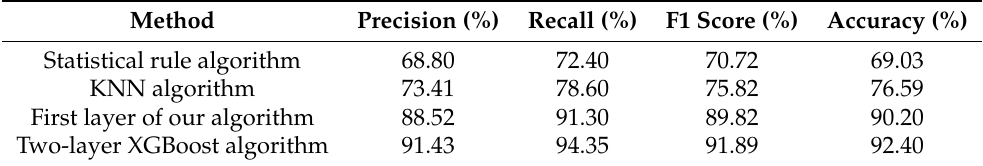
Figure 5. The prediction accuracy of different algorithms for different shopping malls. The red dots represent our two-layer XGBoost algorithm, the blue dots represent the statistical rule algorithm, and the green dots represent the K-nearest neighbor (KNN) classification algorithm. Table 3. The results of different